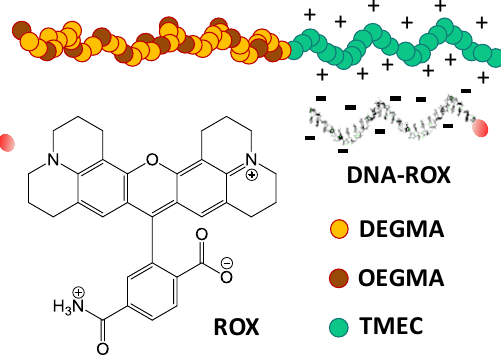
Figure 3. Schematic representation showing the relative scale of the stimuli-responsive block copolymer chain (SRP) and the poly-thymine oligonucleotide labelled with rhodamine X (DNA-ROX).